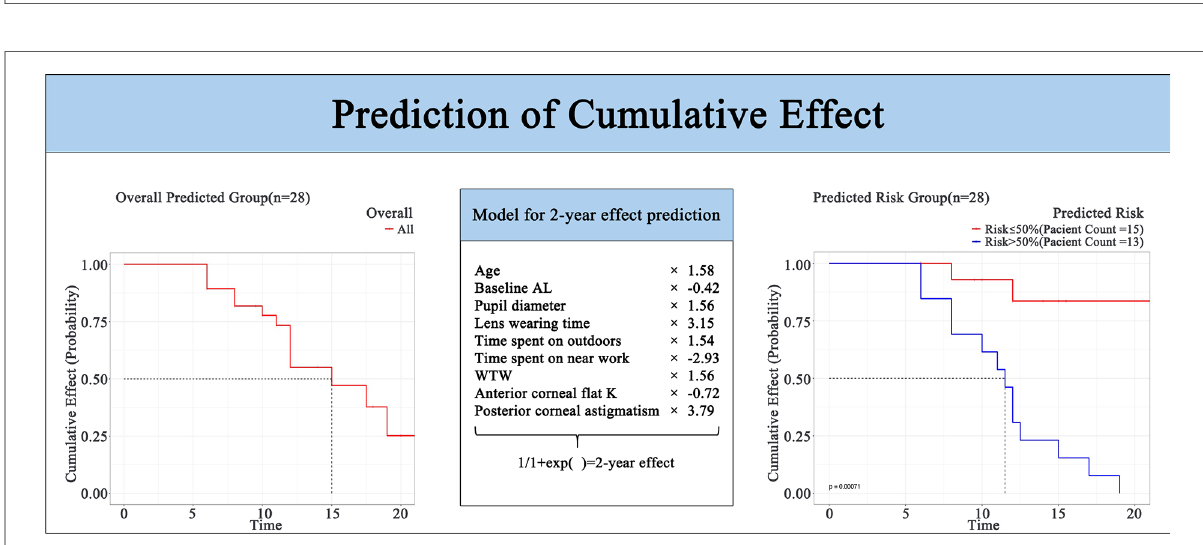
FIGURE 6 Nomogram of the 2-year possibility of the cumulative effect of ortho-k. K, keratometry; WTW, white-white distance; AL, axial